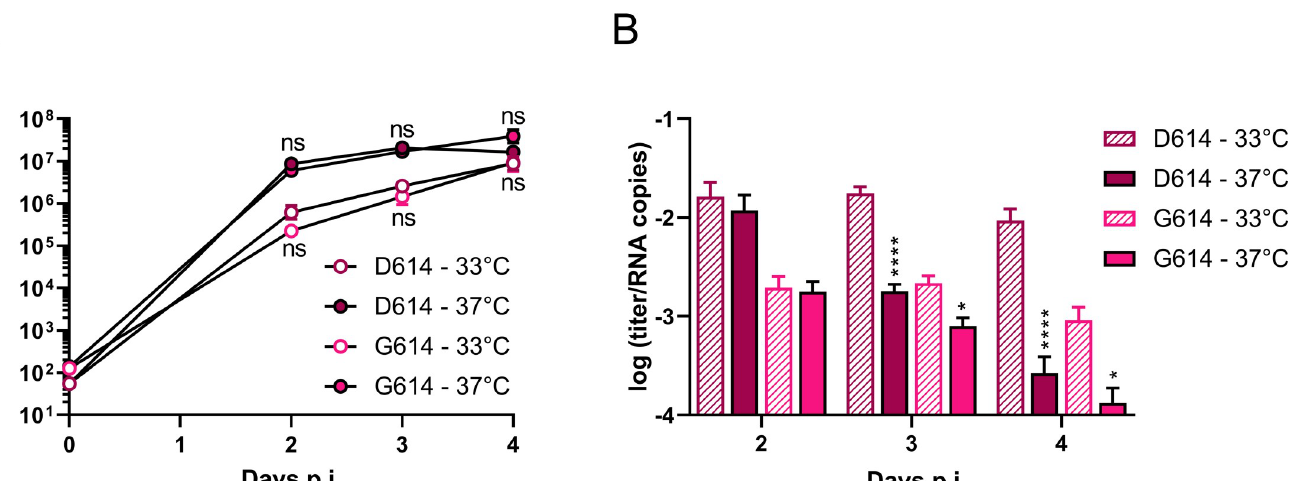
PLOS Pathogens| https://doi.org/10.1371/journal.ppat.1009500 April 22,